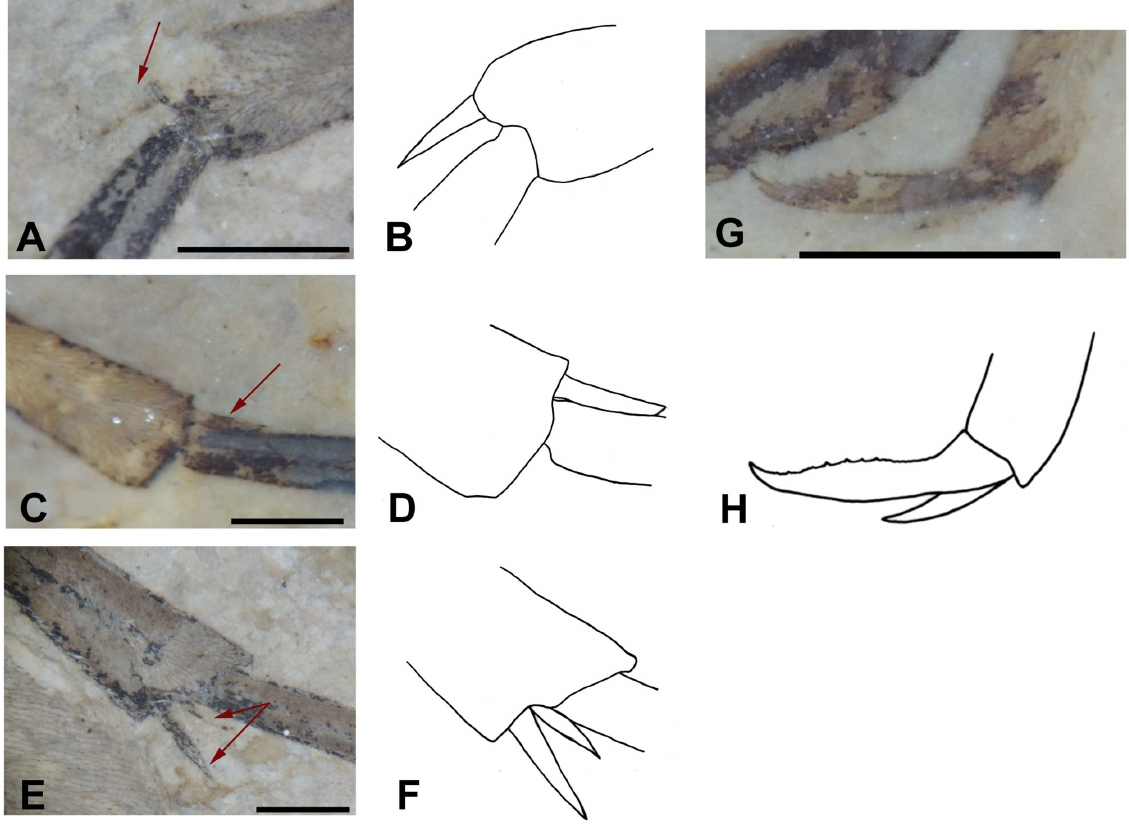
Fig. 4. Archaeoripiphorus nuwa Hsiao, Yu & Deng gen. et sp. nov., holotype. A–F . Tibial spurs (indicated by the red arrows). A–B . Fore leg. C–D . Mid leg. E–F . Hind leg. G–H . Tarsal claw of mid leg. A, C, E, G. Photographs. B, D, F, H. Hand drawings. Scale bars: